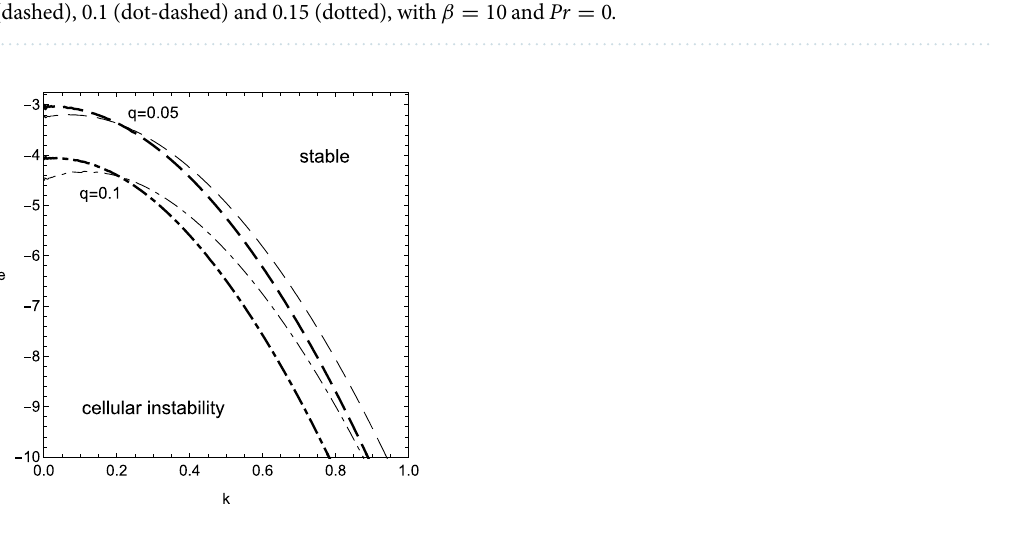
Figure 2. The same as Fig. 1 but for two values of Prandtl number, Pr